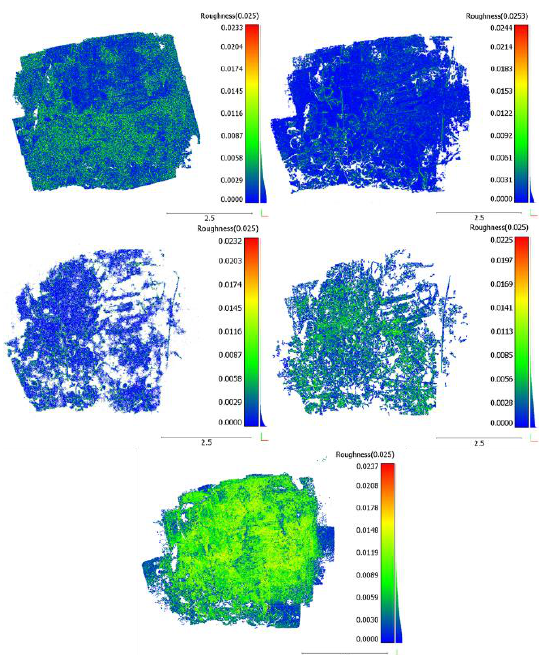
Figure 4: Roughness of all the points in the Dense Clouds. Upper left: Photoscan, Upper right: Reality Capture, Middle Left: 3D Zephyr, Middle right: VSFM, Bottom: SURE Regarding the surface density as it is shown in Table 1, SURE has the biggest mean number of neighbours for every point with 2.2 million. Reality Capture and Photoscan have a mean density of 98k and 90k respectively where 3D Zephyr and VSFM have 20k and 30 k respectively. Based on the number of points per dense cloud, the surface density metrics are nothing out of the ordinary.